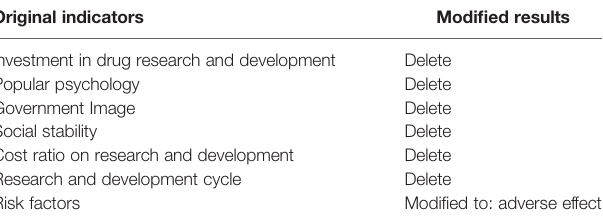
TABLE 4 | Indicator changes in two Delphi